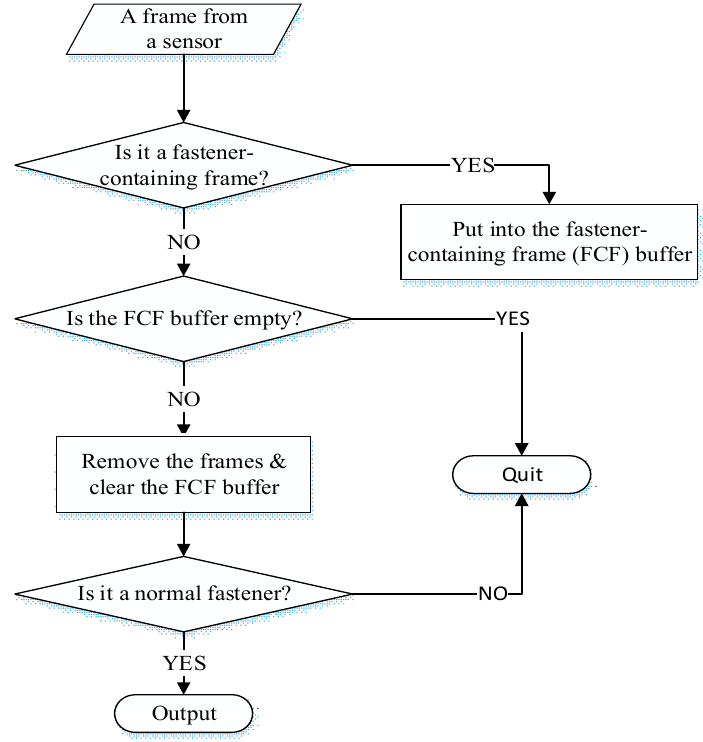
Figure 9. Overall steps of fastener extraction method.